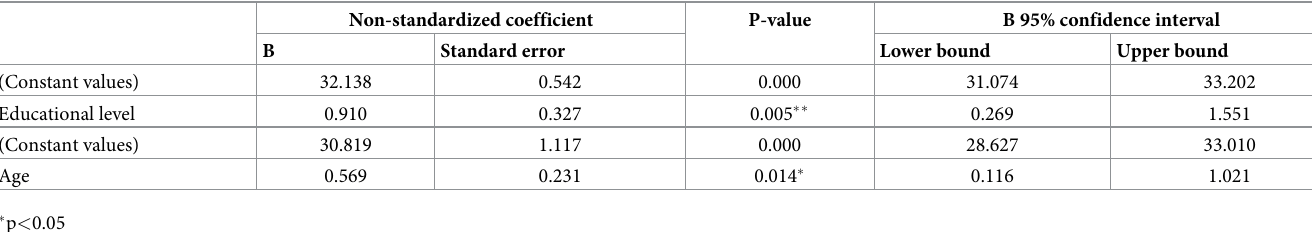
Table 2. Univariate linear regression analysis of health literacy, predictive factors.